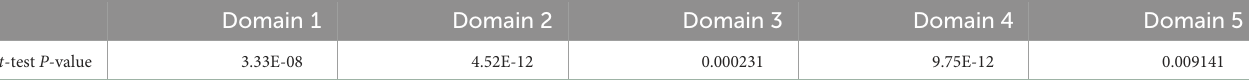
TABLE 5 One-sided Welch’s t -test P -value.